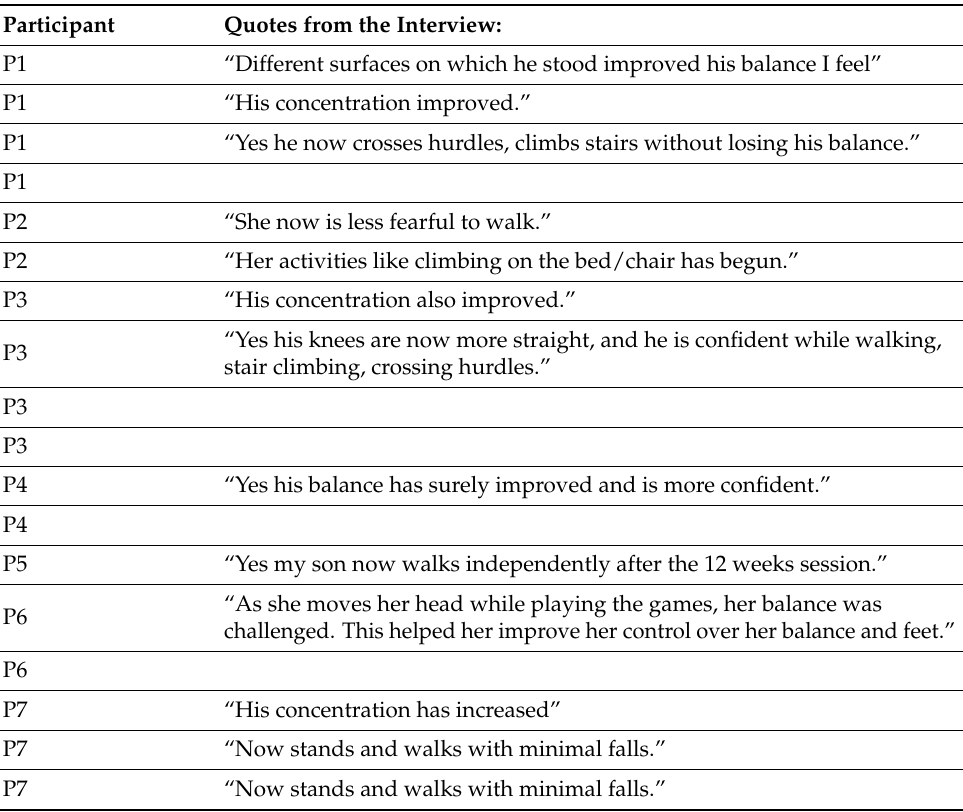
Table 4. Effects of the game-based exercise